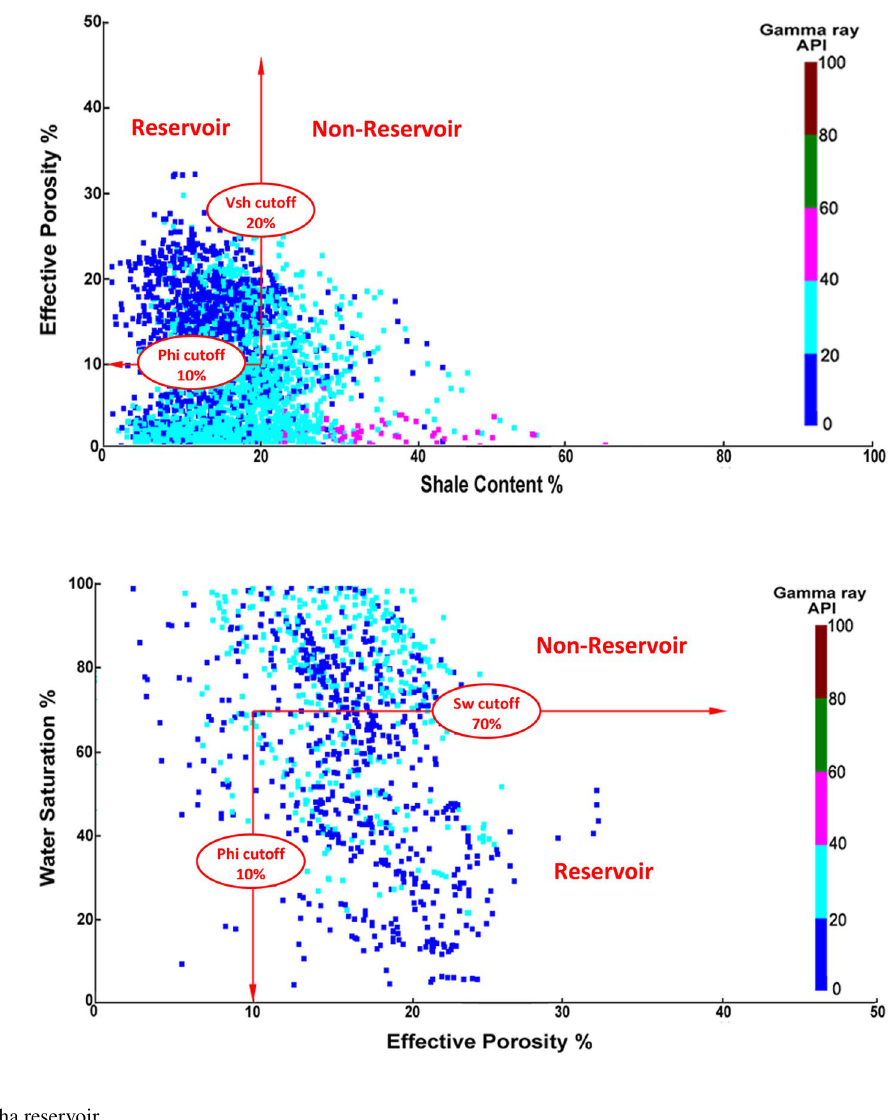
Fig. 12 Cross-plot of the shale content as a function in porosity accompanied with the gamma ray scale for cutoff determina- tion